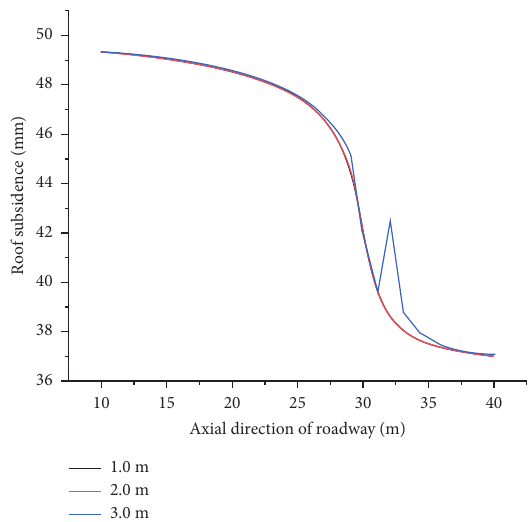
Figure 15: The deformation curve of the roof under the three kinds of unsupported roof distances.